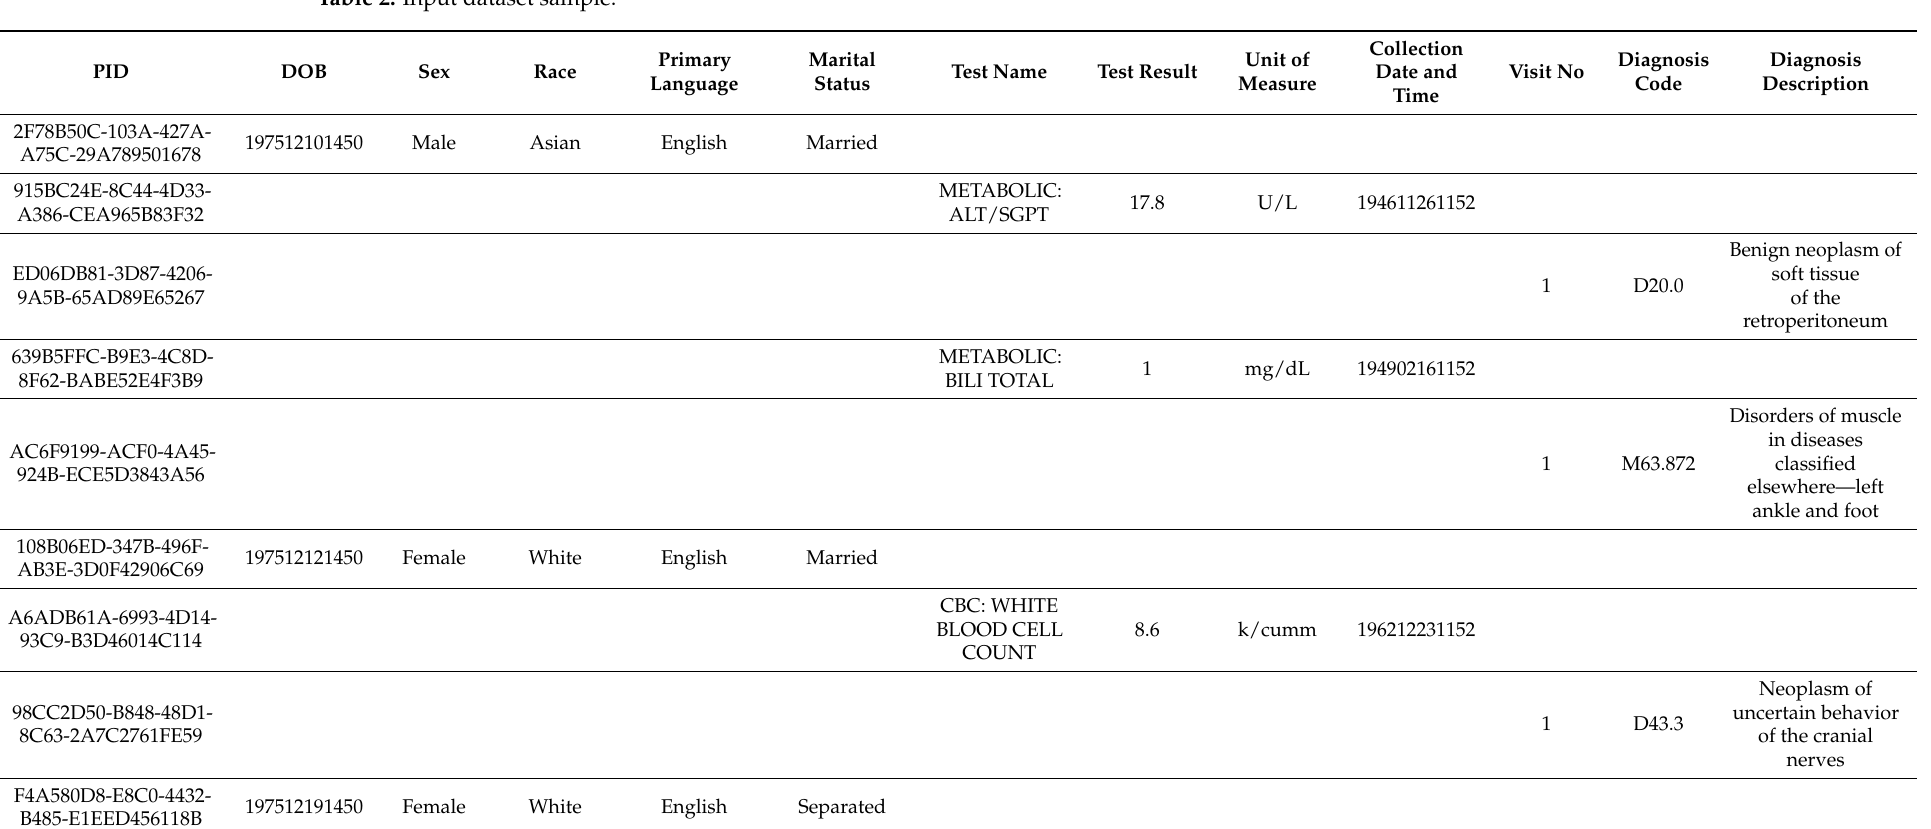
Table 2. Input dataset